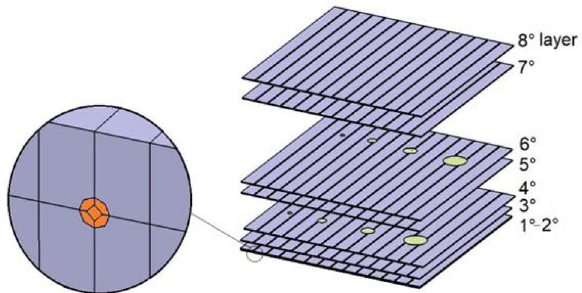
Fig. 7 Geometrical model generation with insertion of SMA wires and artificial defects between the 4th and 5th layers and between the 6th and 7th layers